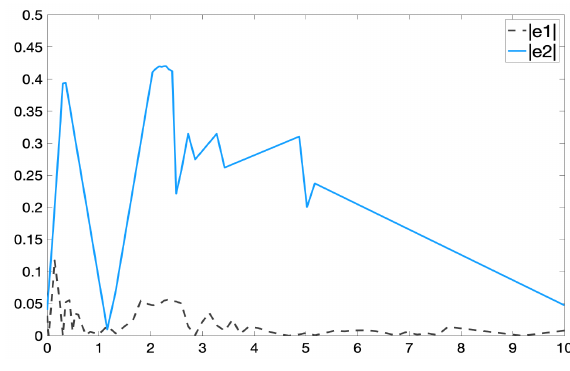
Figure 5. Dynamic quantizer quantization error.